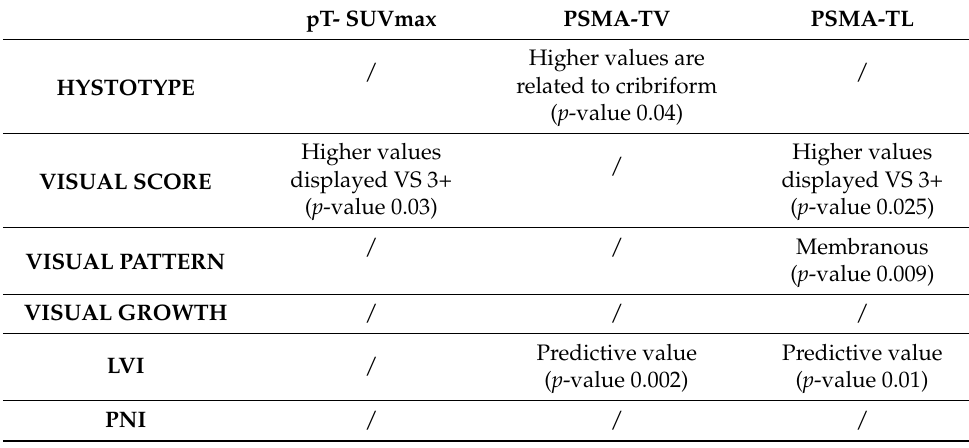
Table 5. Correlations among PET-parameters and histopathology